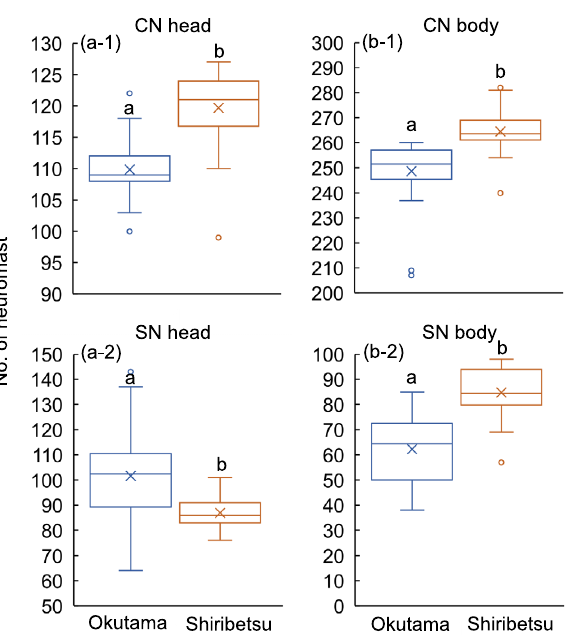
Figure 2. Comparisons of neuromast numbers (CNs and SNs) on the head and body of wild Oncorhynchus masou masou from Okutama and Shiribetsu regions. Different letters (a, b) indicate significant difference detected by univariate ANOVA (p < 0.05). Boxplots show 25, 50 and 75 percentiles, maximum and minimum values without considering outliers, and mean values (X).